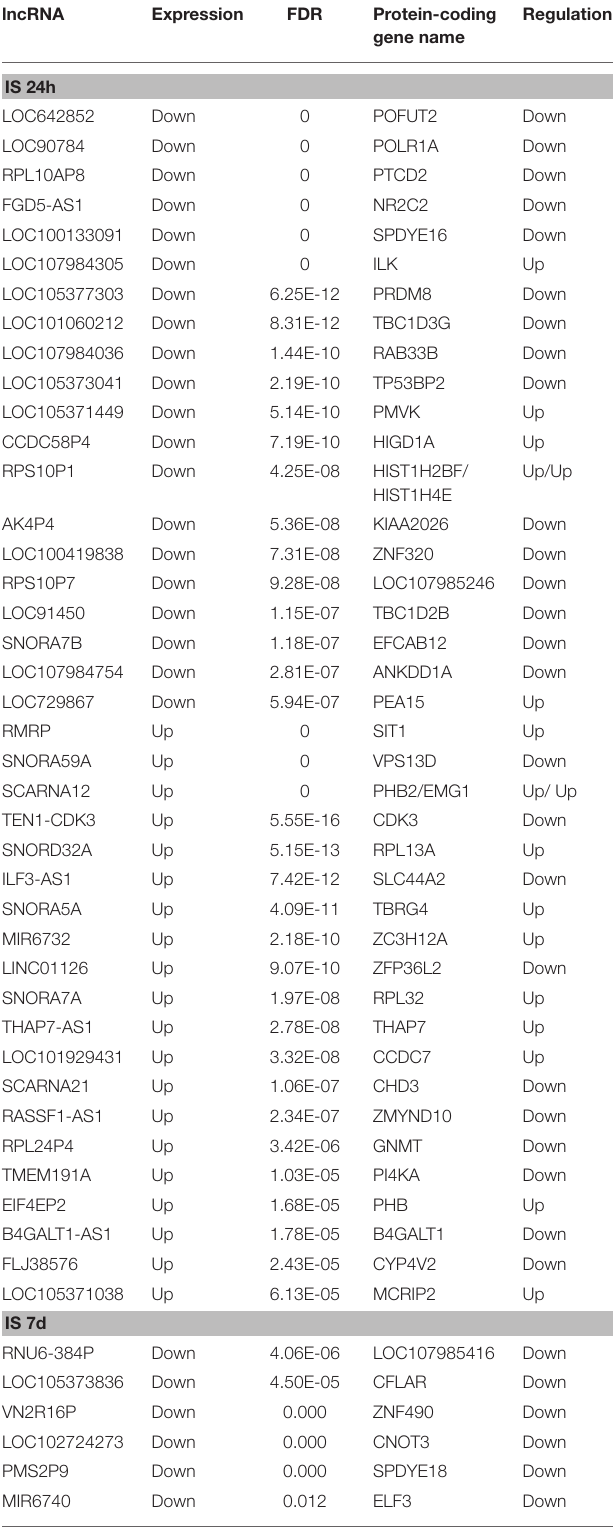
TABLE 5 | Top 20 differentially expressed LncRNAs and adjacent coexpressed mRNAs. lncRNA FDR Protein-coding